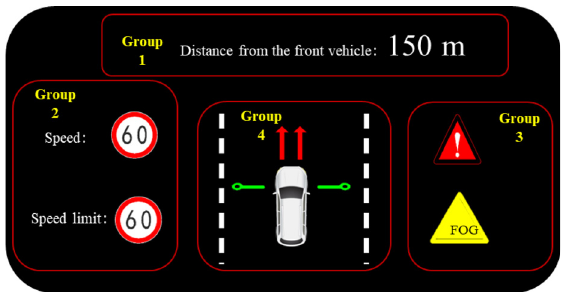
Figure 4 Symbol display of HMI